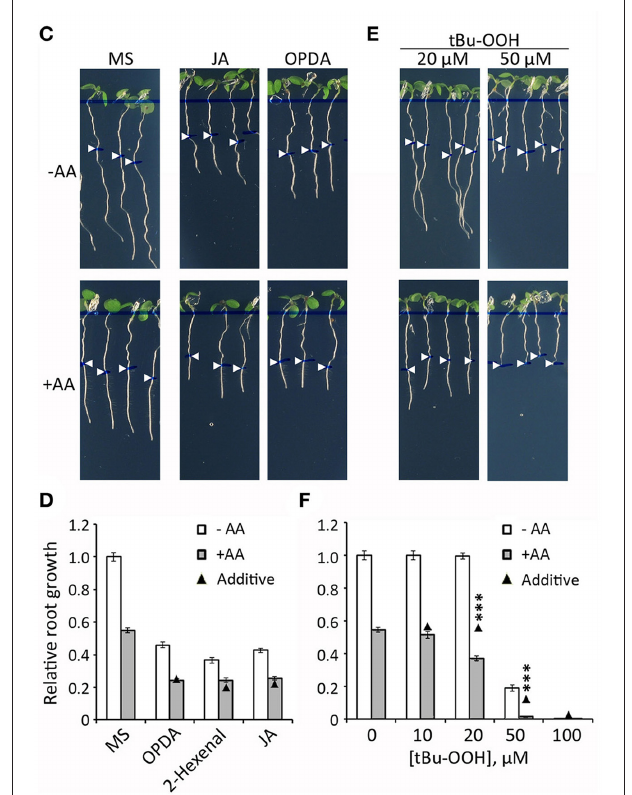
FIGURE 4 | Root growth phenotype in seedlings treated with oxylipins and AA. (A) Root phenotypes of wild type plants grown for 4 days on MS medium and then transferred to MS or MS with 2.5 µ M AA, 12.5 µ M 9-HOT or AA + 9-HOT. (B) Root growth (relative to MS) of wild type plants in MS, 9-HOT, 9-KOT, 13-HOT, 13-KOT, 10-HOT, 12-HOT, 15/16-HOT, LNA and 2-HOT, alone or in combination with 2.5 µ M AA. Oxylipins and LNA were used at 12.5 µ M. (C) Root phenotypes of wild type plants grown for 3 days on MS medium and then transferred to MS, or to MS with 1 µ M OPDA or 10 µ M JA, alone or in combination with 2.5 µ M AA. (D) Root growth (relative to MS) of wild type plants in MS, 1 µ M OPDA, 12.5 µ M 2-hexenal or 10 µ M JA, alone or in combination with 2.5 µ M AA. (E) Root phenotypes and (F) root growth (relative to MS) of wild type plants in different concentrations of tBuOOH, alone or in combination with 2.5 µ M AA. In all cases, pictures and measurements were taken on plants 3 days after passing to the indicated media. In (A,C,E) root lengths at the moment of medium transfer are pointed by white arrowheads. In (B,D,F) black triangles represent expected root growths in combined treatments if both effects were additive (no interaction). Asterisks represent a significant interaction between treatments ( n ≥ 8, Two way ANOVA, *** P < 0.001, ** P < 0.01, * P < 0.05).